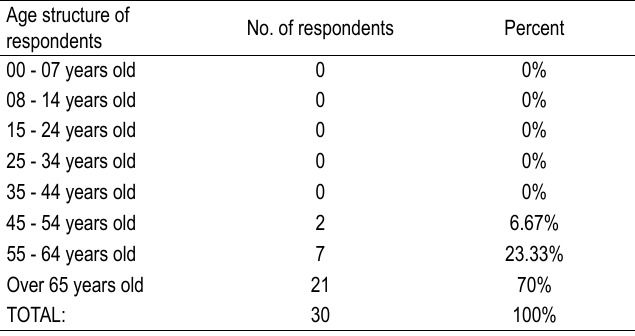
Table 3. Age structure of respondents